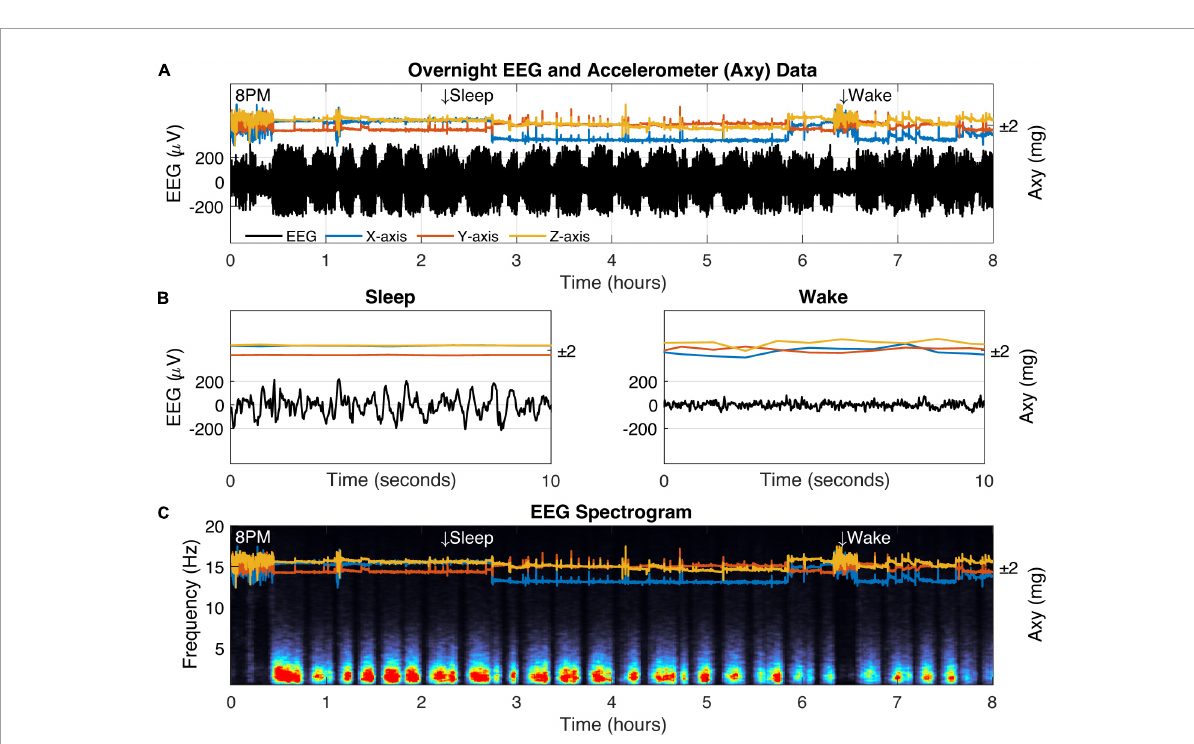
FIGURE5 Biologging overnight in a freely behaving captive fox squirrel. (A) Eight hours of biologger data beginning at 8 p.m. showing EEG data (black) and 3D accelerometer data from the x -axis (blue), y -axis (orange), and z -axis (yellow). Representative sleep and wake epochs are marked along the top and the same data is shown in where (B) time has been restricted to a 10-s window. (C) The EEG spectrogram showing the relative power for each frequency (1–20 Hz) across time (red colors indicate high